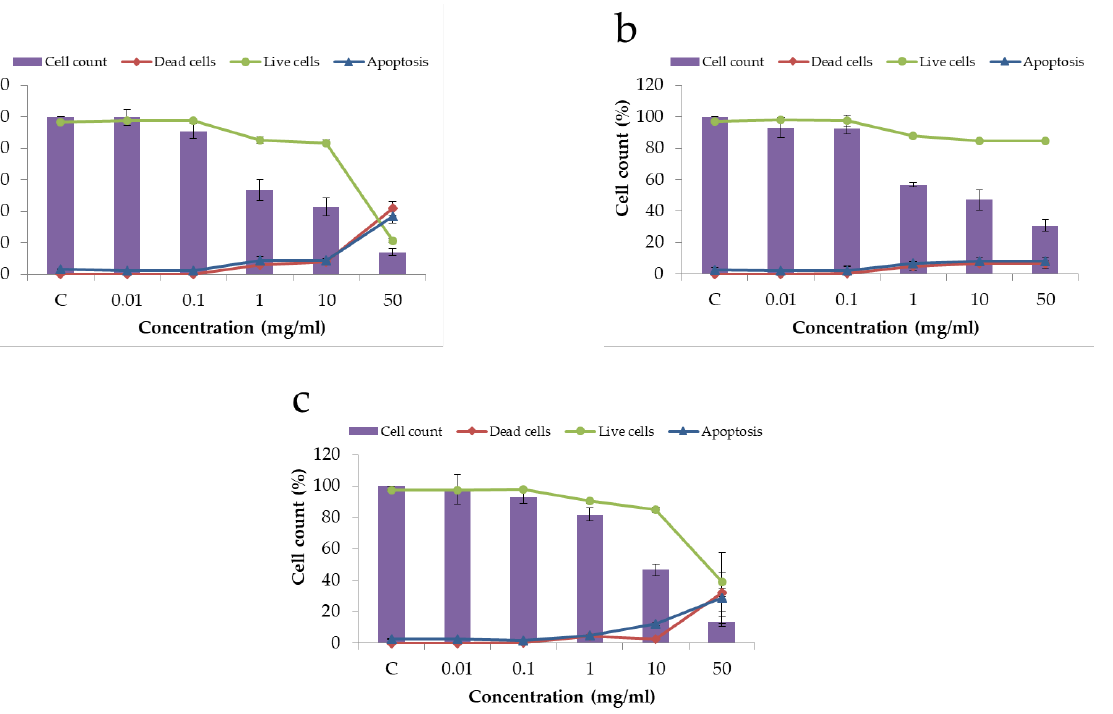
Figure 7. Cell viability of Hek293 cells incubated with HA ( a ), 0.2-ZnSi-HA ( b ), or 1.0-ZnSi-HA ( c ) for 48 h.